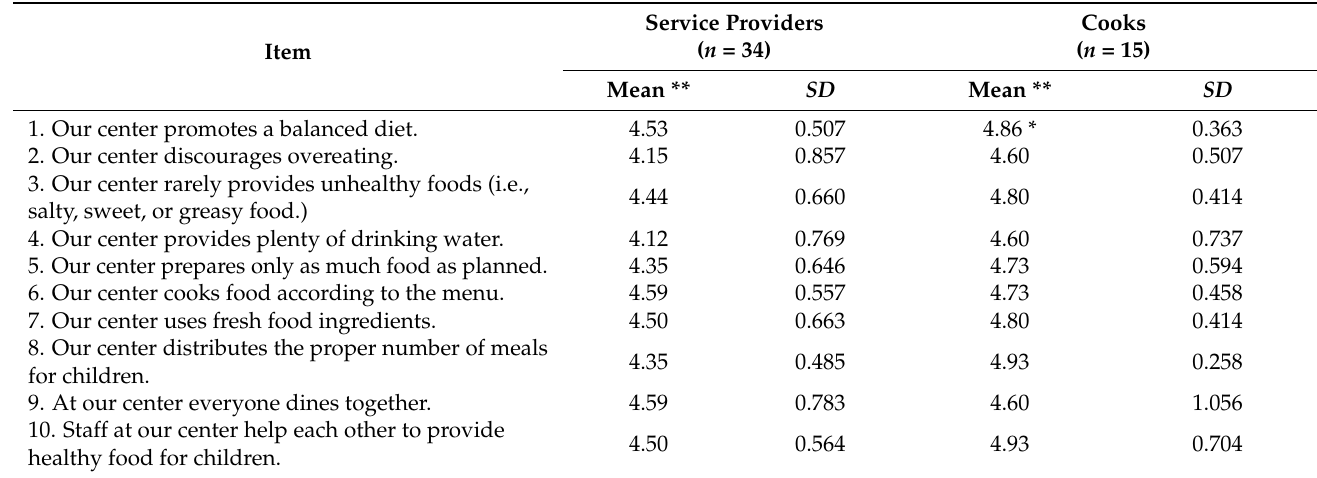
Table 2. CCCs’ eating practices reported by service providers and cooks.